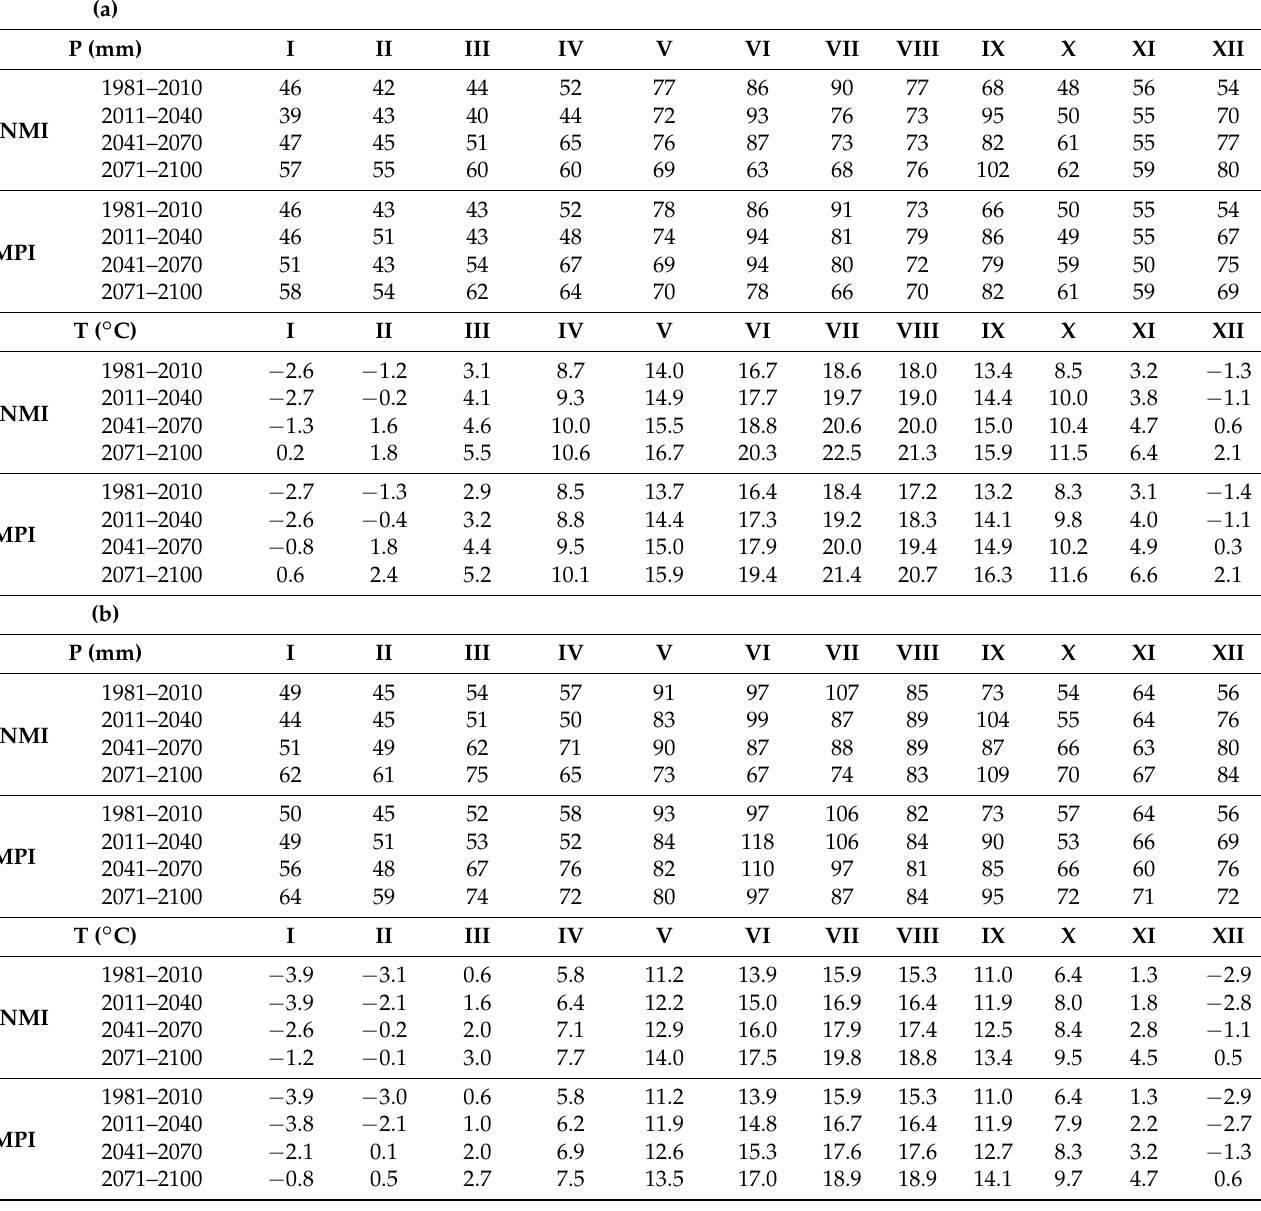
Table 3. The long-term mean monthly values of the precipitation (P) and air temperature (T) for the reference period